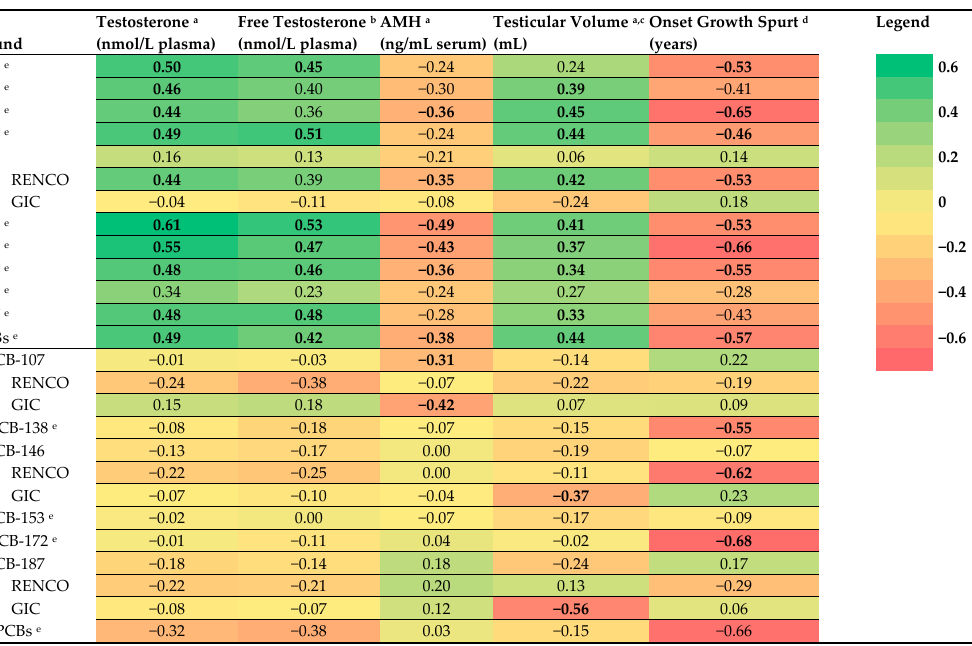
Figure 1. Heat map of adjusted beta coefficients obtained from linear regression analyses performed between log10 transformed prenatal levels of polychlorinated biphenyls (PCBs) and hydroxylated PCBs (OH-PCBs) and reproductive hormone levels and pubertal characteristics in boys. AMH: anti-müllerian hormone; associations with a p -value < 0.10 are shown in bold; a adjusted for age at examination; b adjusted for age and body mass index (BMI); c volume of the largest testicle and measured with an orchidometer; d adjusted for BMI and onset paternal growth spurt; only boys who reported ‘yes’ on the question whether they mentioned onset of growth spurt were included; RENCO cohort: Risk of Endocrine Contaminants on Human Health cohort; GIC cohort: Groningen-Infant-COMPARE (Comparison of Exposure-Effect Pathways to Improve the Assessment of Human Health Risks of Complex Environmental Mixtures of Organohalogens) cohort; e RENCO cohort.